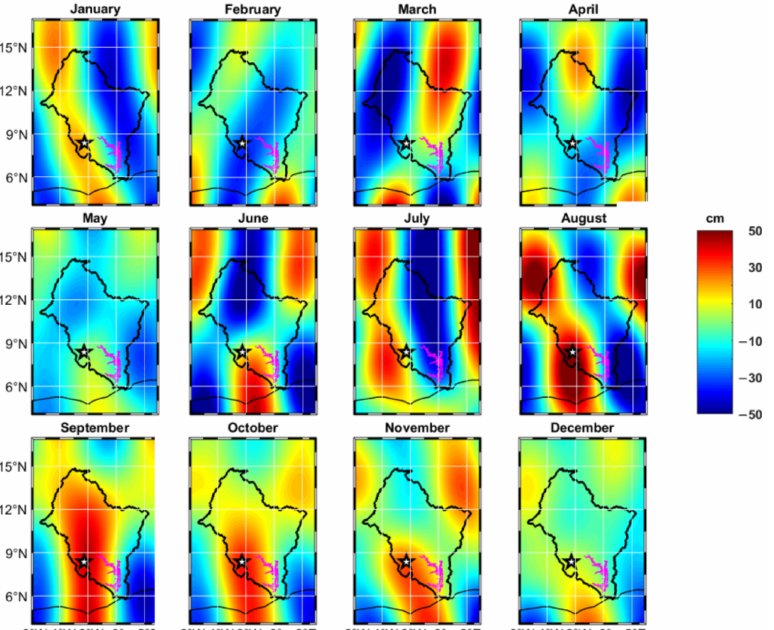
Figure 7. The raw GRACE estimated monthly mass changes with seasonal variations removed during the period from January 2012 to December 2012. All the plots have been deduced from the mean of the first 4 months in 2012. The location of the Bui Reservoir is marked with a white star. The pink area represents the Volta Lake.